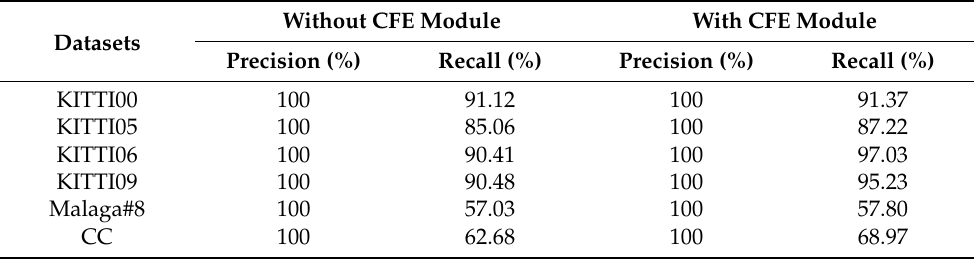
Table 2. The comparative results of the global feature ranking branch with and without the CFE module on six datasets.